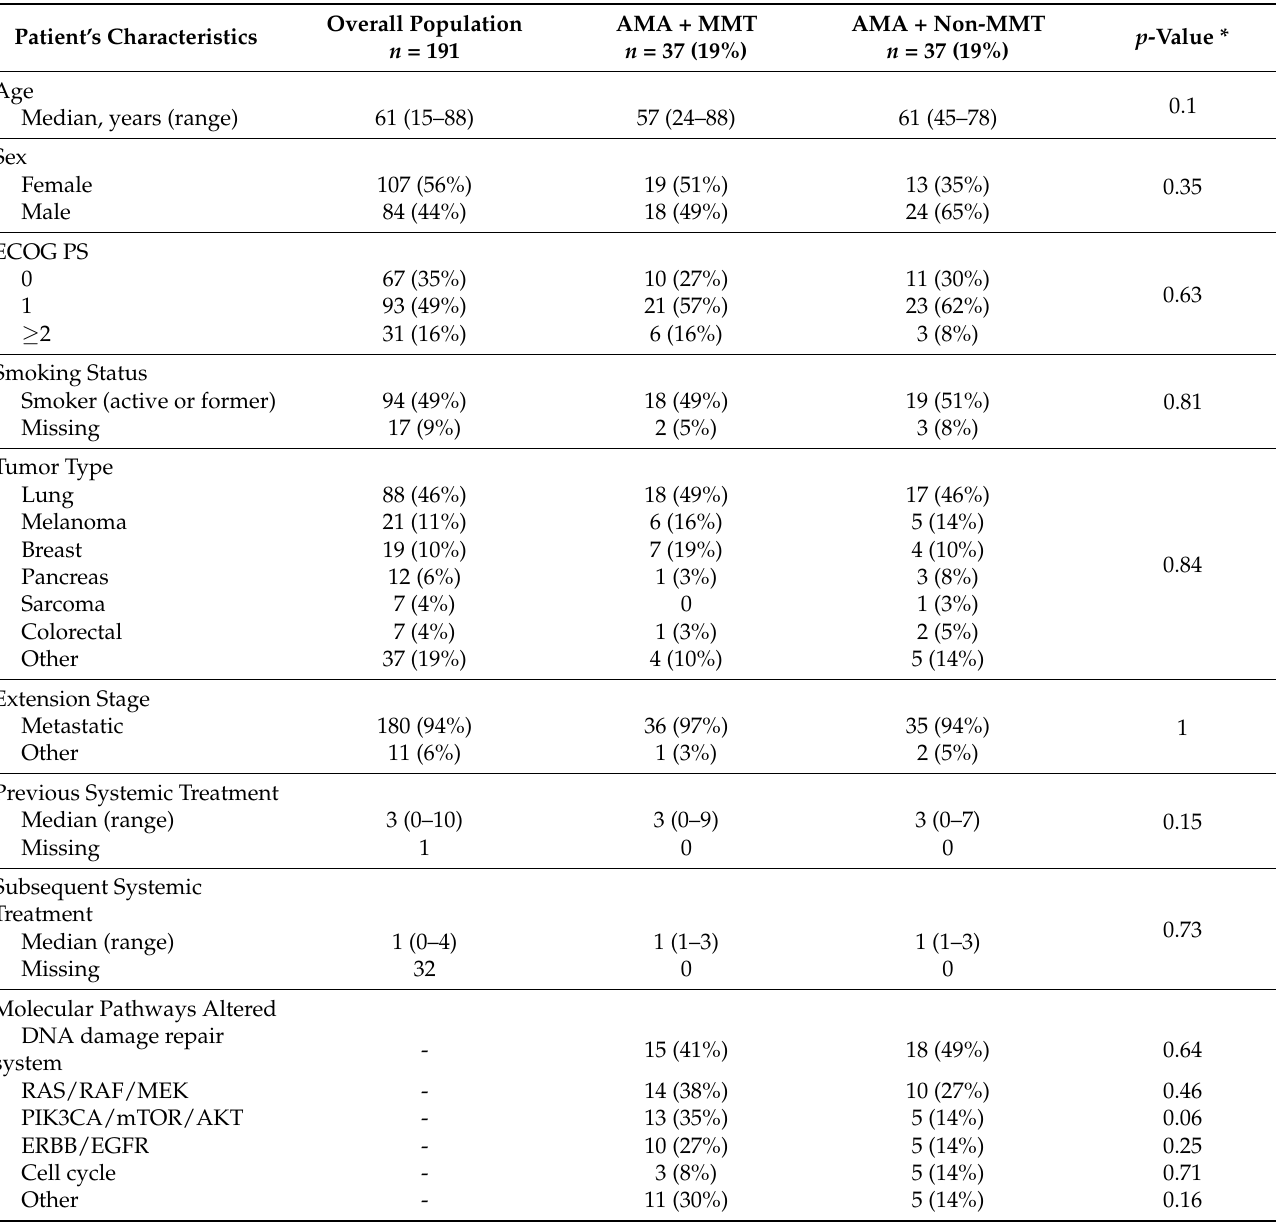
Table 1. Patient’s